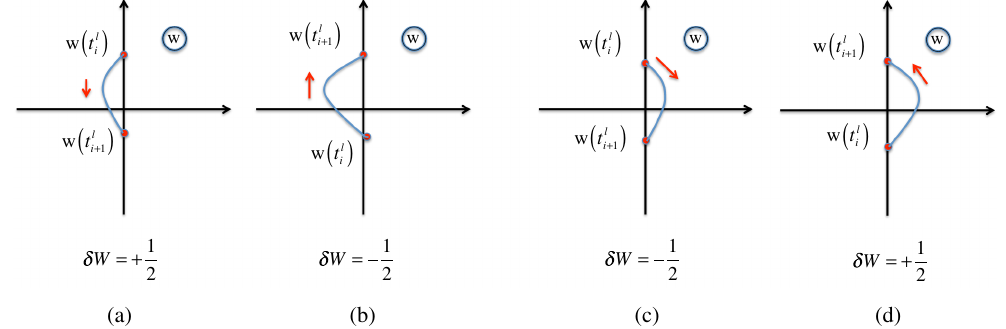
FIG. 9. The pairs of intersections that affect the winding number of the contour. Parts (a) and (b) are the odd pair, i ¼ 2 j (cid:3) 1 . Parts (c) and (d) are the even pair, i ¼ 2 j